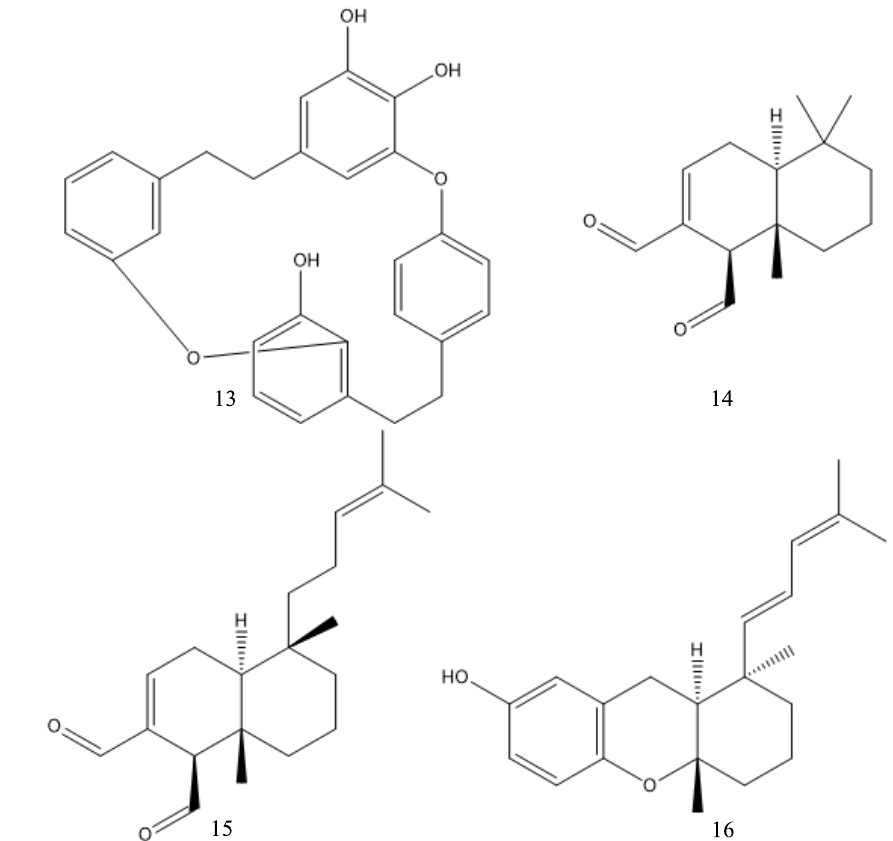
Figure 2. Chemical structures of compounds mentioned in Table 4 ( 13 : marchantin A; 14 :